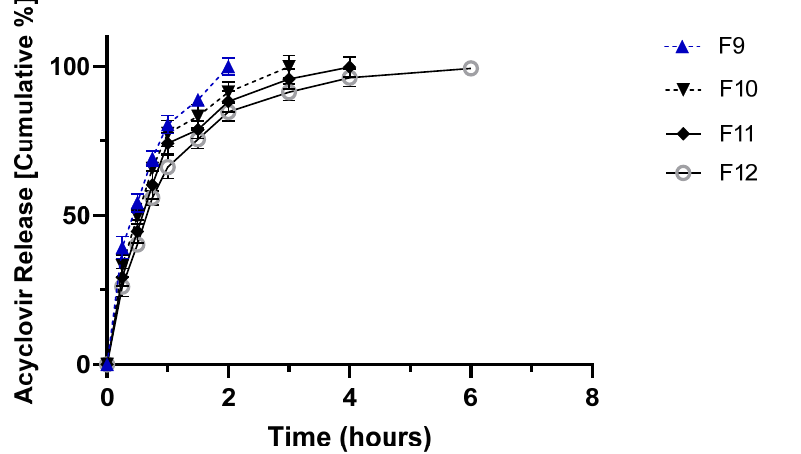
Figure 3. In vitro release profile of acyclovir from Carbopol tablets (F-5 to F-8) in 0.1 N HCl (pH 1.2) from zero to two hours, after which 200 mL of 0.2 M sodium phosphate tribasic solution was added to reach a final pH of 7.4 kept for the remaining 24 h. Please refer to Table 7 for tablets’ composition.